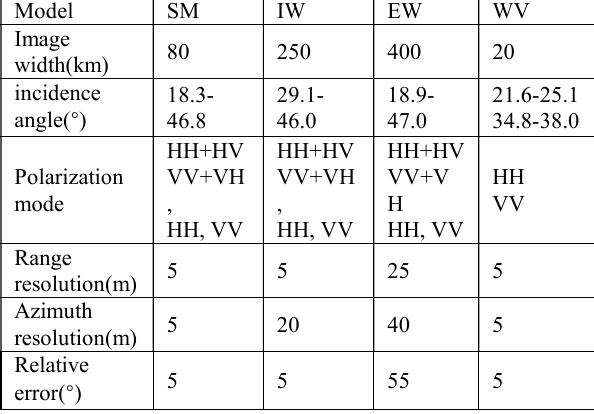
Table 3. Main parameters of Sentinel-1A satellite